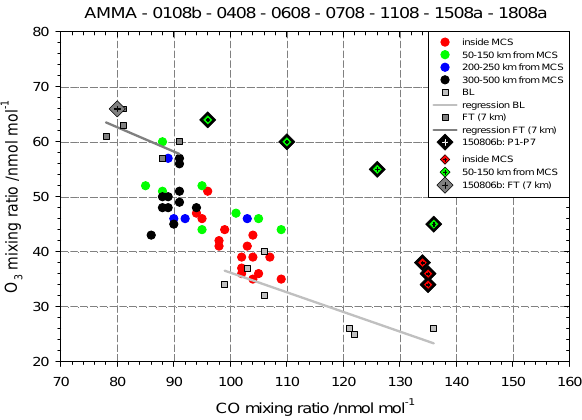
Fig. 15. CO-O 3 correlations during single penetrations of MCS outflow on selected AMMA Falcon flights 2006 as indicated in the header and legend. Flights listed in the header are represented by dots in different colours depending on the distance from the MCS. Superimposed are the correlations in the free troposphere (FT) and boundary layer (BL) for the selected flights in the header and their regressions (dark and light grey squares). The flight listed in the legend (150806b) is represented by a black diamond superimposed by smaller coloured diamonds depending on the distance from the MCS. The grey diamond represents the correlation in the FT for this flight.